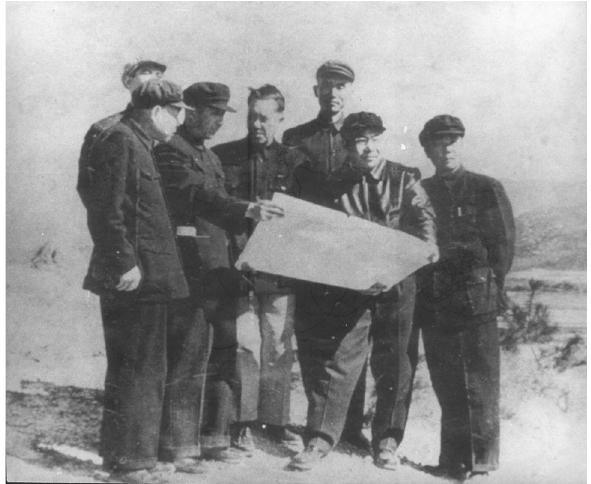
Figure 3. Prof. Huan-Yong Chen (in the middle ) was discussing the design of the landscape for SCBG with colleagues in 1956.